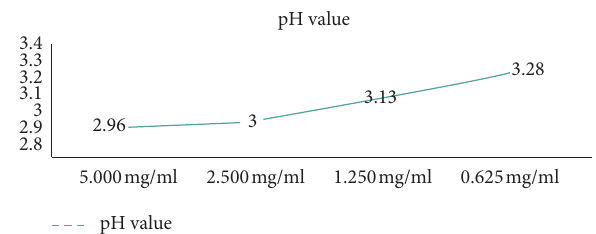
Figure 2: pH test results of different concentrations of the